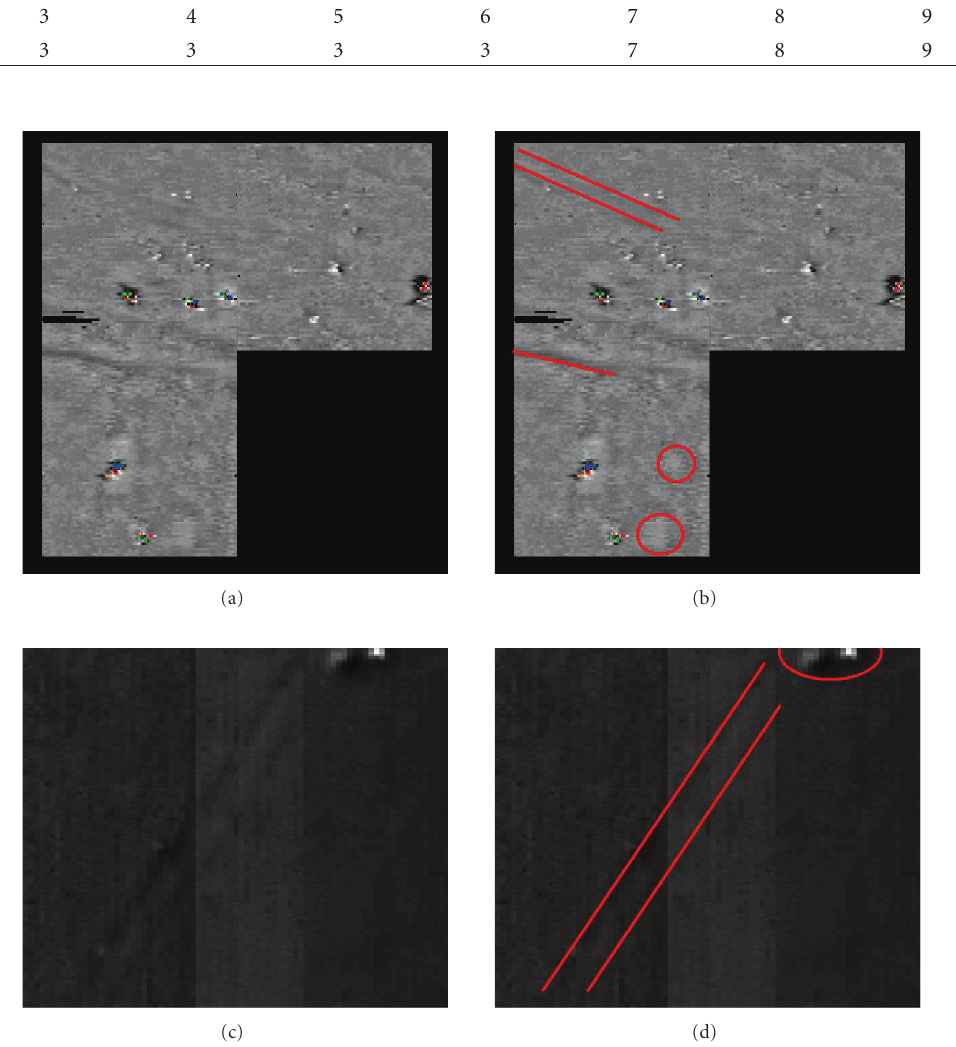
Figure 8: (a) Graphical representation of data gathered at Goetz grids D, E, and F. (b) Expert opinion on archaeological features of interest contained in magnetometer data from part (a). (c) Graphical representation of data gathered at Goetz, grid C. (d) Expert opinion on archaeological features of interest contained in magnetometer data from part (c). Red, blue, and green pixels represent readings of metallic objects in the scan field; red lines and circled areas represent features of interest.